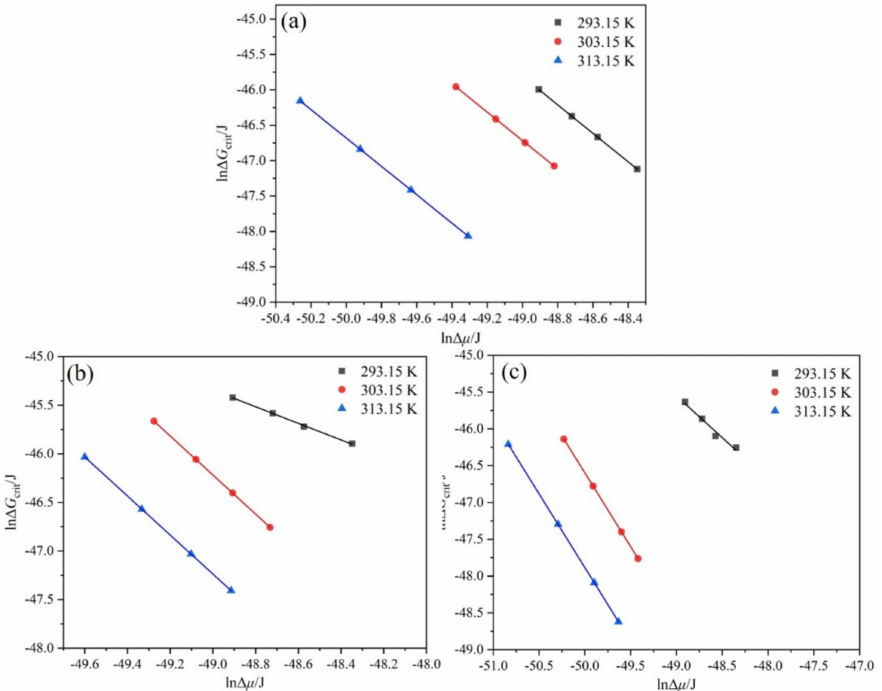
Figure 14. Relationship between ln ∆ G crit and ln ∆ µ at different T 0 : ( a ) ethanol mass fraction of 0.6,